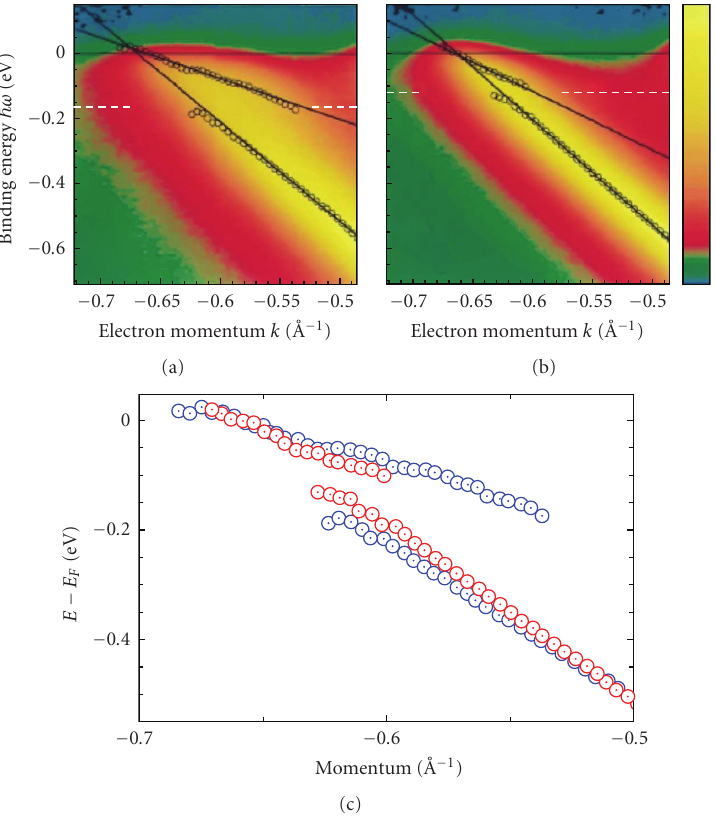
Figure 5: (a-b) ARPES dispersions of a surface state for (a) H monolayer on W and (b) D monolayer on W. The dispersions are determined by peak positions from EDC fits and appear as circles while the lines serve as guides to the eye. (c) These two dispersions are compared where H = blue and D = red. The figure is from